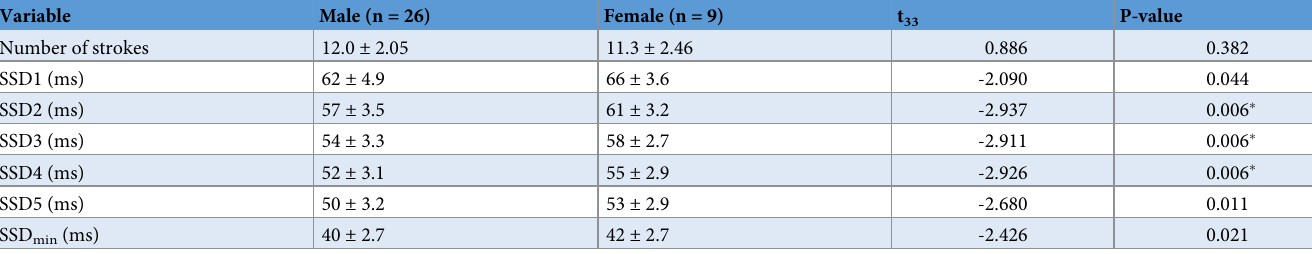
males and females. We found that males had slightly but significantly shorter SSDs, but the range overlapped between males and females (Table 3). In a stepwise DFA, only one predictor—SSD2—was selected into the model. DFA correctly classified sex of individuals based on SSD2 in 82.9% of cases (82.9% in leave-one-out classification) (Wilks’ lambda = 0.798, Table 3. Differences in drumming characteristics between males and